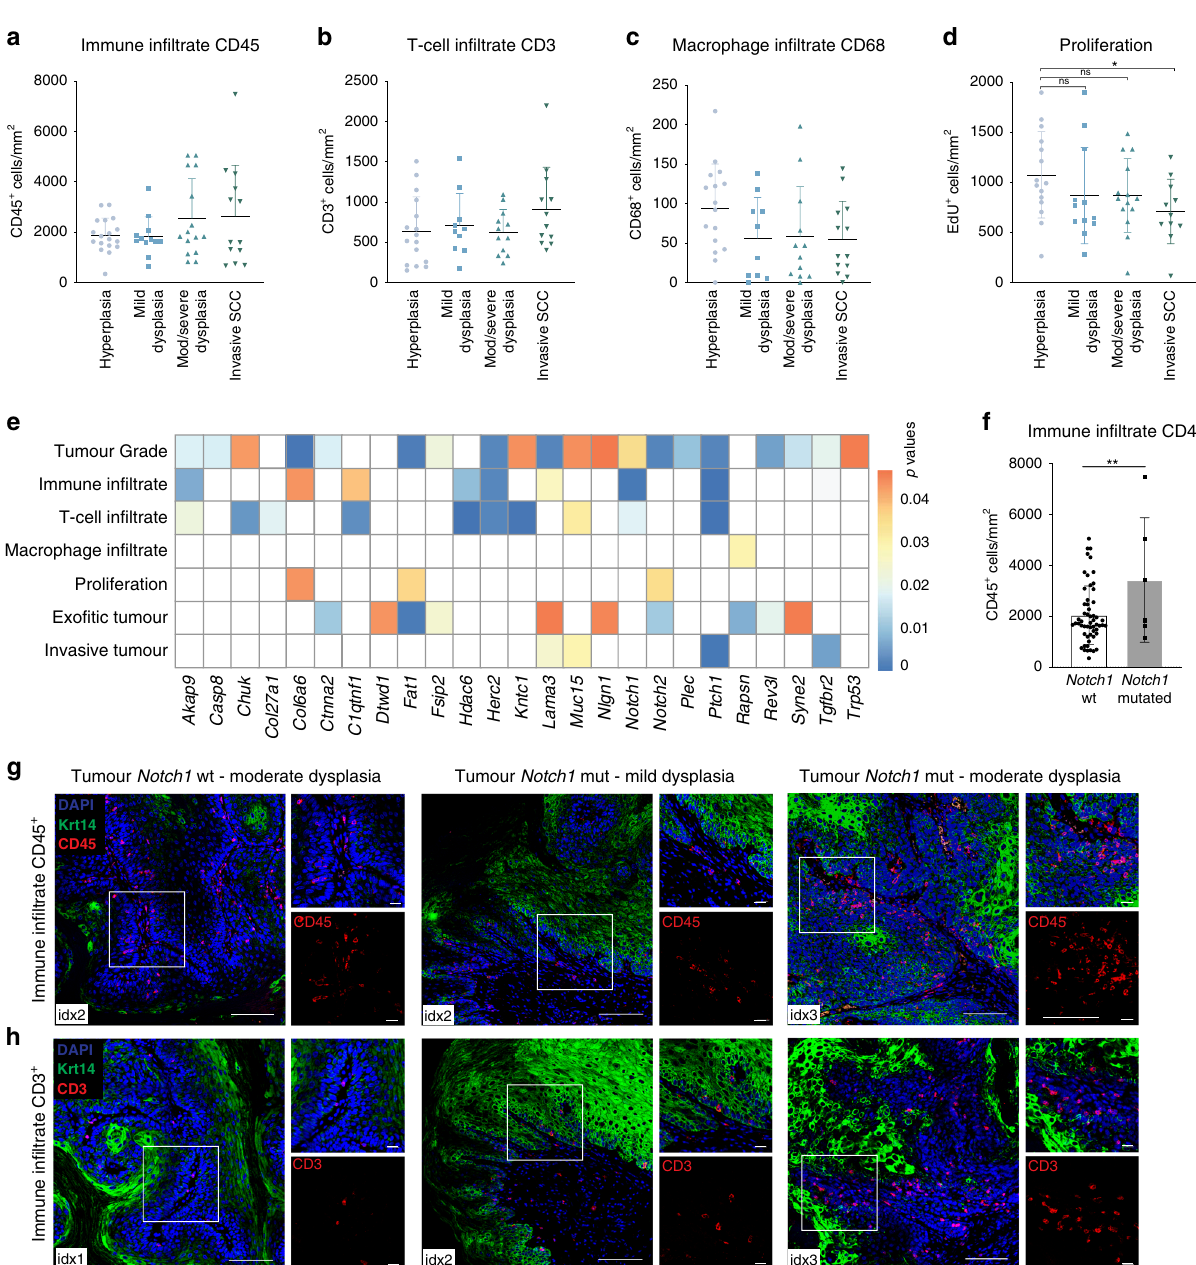
Fig. 5 Correlation between mutational landscape and tumour ecology. a – c Quanti fi cation of immune in fi ltrate (CD45 + cells/mm 2 ), T-cell in fi ltrate (CD3 + cells/mm 2 ) and macrophage in fi ltrate (CD68 + cells/mm 2 ) in the different tumour grades (hyperplasia n = 18, mild dysplasia n = 12, moderate/ severe dysplasia n = 16, invasive SCC n = 12 mice, 2 sections/mouse and >6 fi elds quanti fi ed per section; means ± SD are shown, non-signi fi cant, one-way ANOVA). d Quanti fi cation of proliferation (EdU + cells/mm 2 in the different tumour grades (hyperplasia n = 15, mild dysplasia n = 12, moderate/severe dysplasia n = 14, invasive SCC n = 11, 2 sections/mouse and >6 fi elds quanti fi ed per section; means ± SD are shown. Group comparison with one-way ANOVA, non-signi fi cant. Multiple comparison: unpaired t -tests between each grade, non-signi fi cant for all except between invasive SCC and hyperplasia, * p < 0.05, p = 0.0262). e Linear regression analysis to establish the relationship between the total number of mutations in each gene (columns) and the clinical parameters (rows). The heatmap shows the p -value for each correlation (Supplementary Data 7). f Comparison of immune in fi ltrate (CD45 + /mm 2 ) between Notch1 mutated and Notch1 non-mutated (wt) tumours ( n = 56 Notch1 wild-type lesions and n = 6 Notch1 mutated lesions. Bar graphs represent mean ± SD, * p < 0.05, p = 0.0083, unpaired one-tailed t -test). g , h Quanti fi cation of immune in fi ltrate of CD45 + cells ( g ) and T-cell in fi ltrate (CD3 + cells) ( h ) in Notch1 mutated tumours. Immuno fl uorescence staining of representative sections of Notch1 wt and Notch1 mutated tumours labelled with anti-krt14 (green) and anti-CD45 or anti-CD3 (red), counterstained with nuclear dye DAPI. Immune in fi ltrate was quanti fi ed by the number of CD45 + or CD3 + cells per mm 2 (Supplementary Fig. 4a, b). All tumours were analysed and for each tumour ≥ 6 regions were quanti fi ed per section ( n = 2 – 3 sections/tumour/staining). g idx2, CD45 + immune in fi ltrate index 2 (2000 – 5000 cells/mm 2 ); idx3, index 3 (5000 – 10,000 cells/mm 2 ); idx4, index 4 (>10,000 cells/mm 2 ). h idx1, CD3 + immune in fi ltrate index 1 (<500cells/mm 2 ); idx2, index 2 (500 – 1000 cells/mm 2 ); idx3, index 3 (>1000 cells/mm 2 ). Scale bars 100 µ m, 20 µ m in magni fi ed